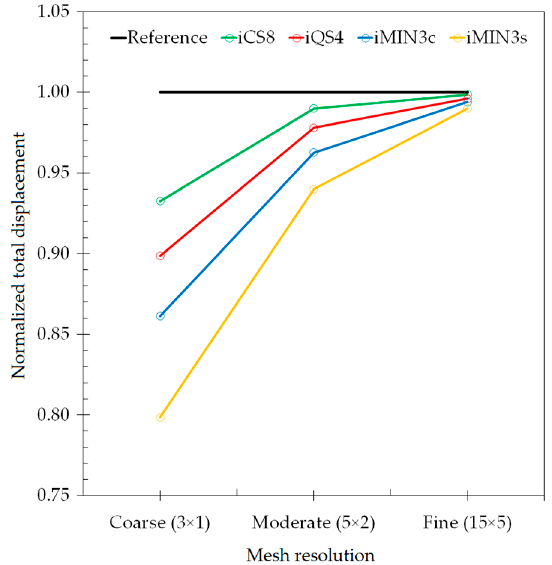
Figure 11. Comparison of normalized total displacements versus increasing mesh resolution for the curved plate.